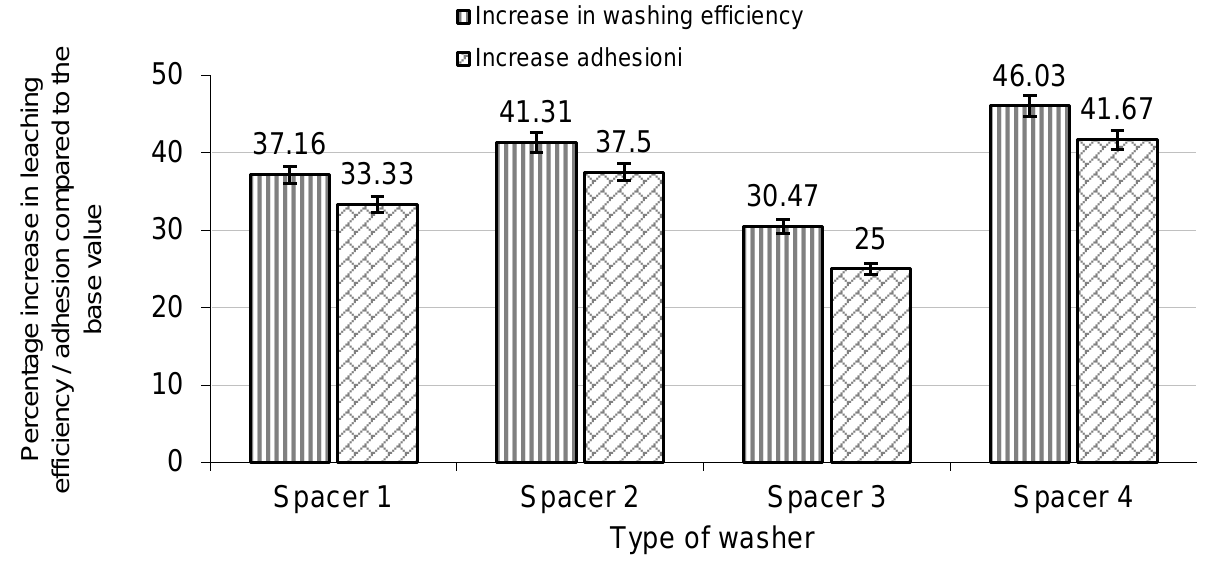
Figure 7. List of the percentage increase of the analyzed parameters (the effectiveness of the removal of mud cake and adhesion on the contact between the hardened cement slurry – the rock core) in relation to the base value.